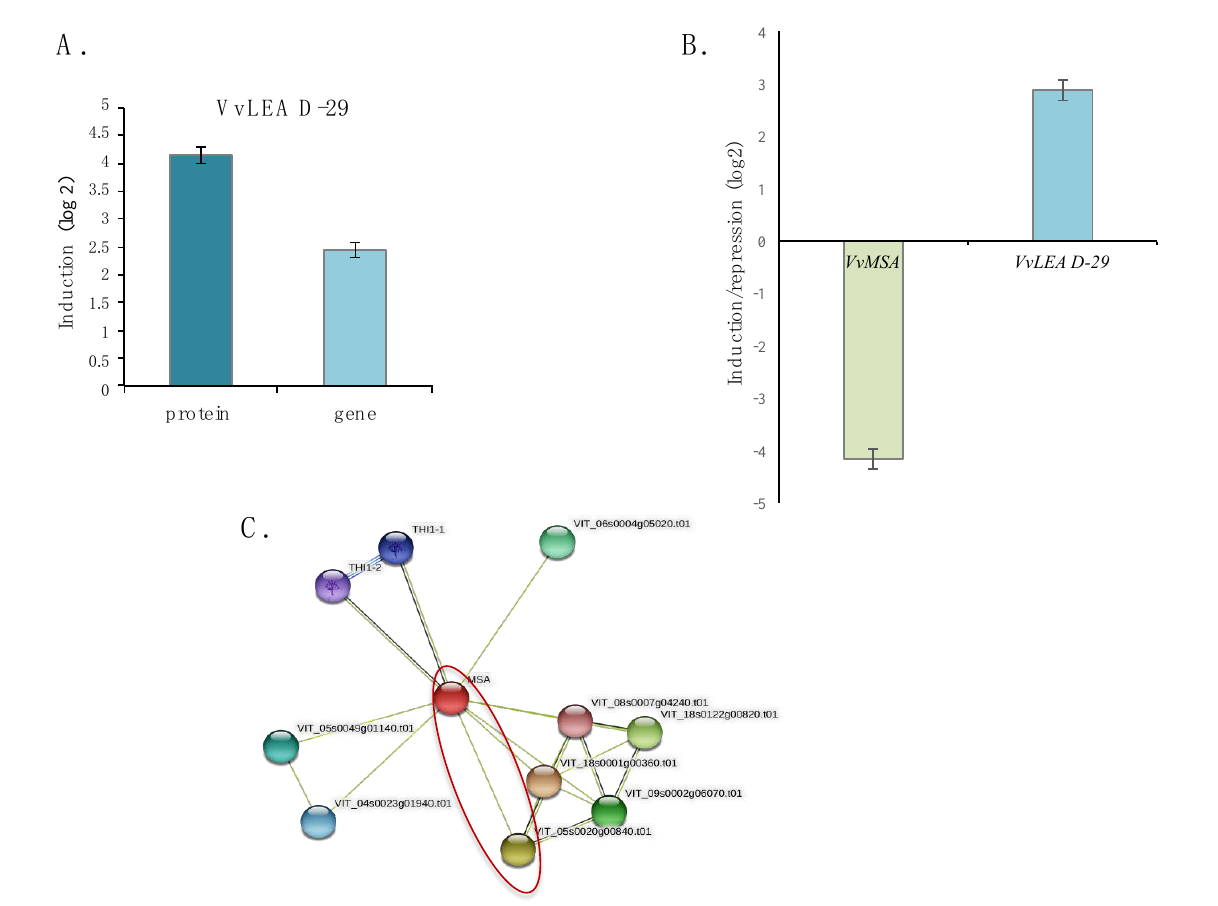
Figure 4. Relationship between VvMSA and VvLEA D-29 genes and proteins. ( A ) Induction of LEA D-29 protein in VvMSA -RNAi silenced cells (quantified by iTRAQ) and LEA D-29 gene expression in VvMSA -RNAi cells (measured by RT-qPCR). The expression of LEA D-29 gene in VvMSA -RNAi cells was reported to that of the control wild-type cells (previously normalized to the reference VvACT gene) and the induction of LEA D-29 (presented on the figure) was then calculated by the 2 - ∆∆Ct method, as log2 fold change (mean ± SE). ( B ) Down-regulation of VvMSA and up-regulation of VvLEA D-29 genes by auxin depletion at the 4th day after somatic embryogenesis induction of wild-type 41B cells (three biological repetitions). The expression of each gene under auxin depletion (previously normalized to the reference VvACT gene) was reported to that of 41B cells cultured into auxin-supplemented medium by using the 2 −ΔΔCt method (mean ± SE). ( C ) Relationship between grape ASR (MSA; VIT_18s0072g00380.t01) and Late Embryogenesis Abundant protein LEA D-29 (VIT_05s0020g00840.t01) established by using the protein – protein interaction and functional enrichment network STRING (https://string-db.org/; accessed on 1 May 2021) in Vitis vinifera